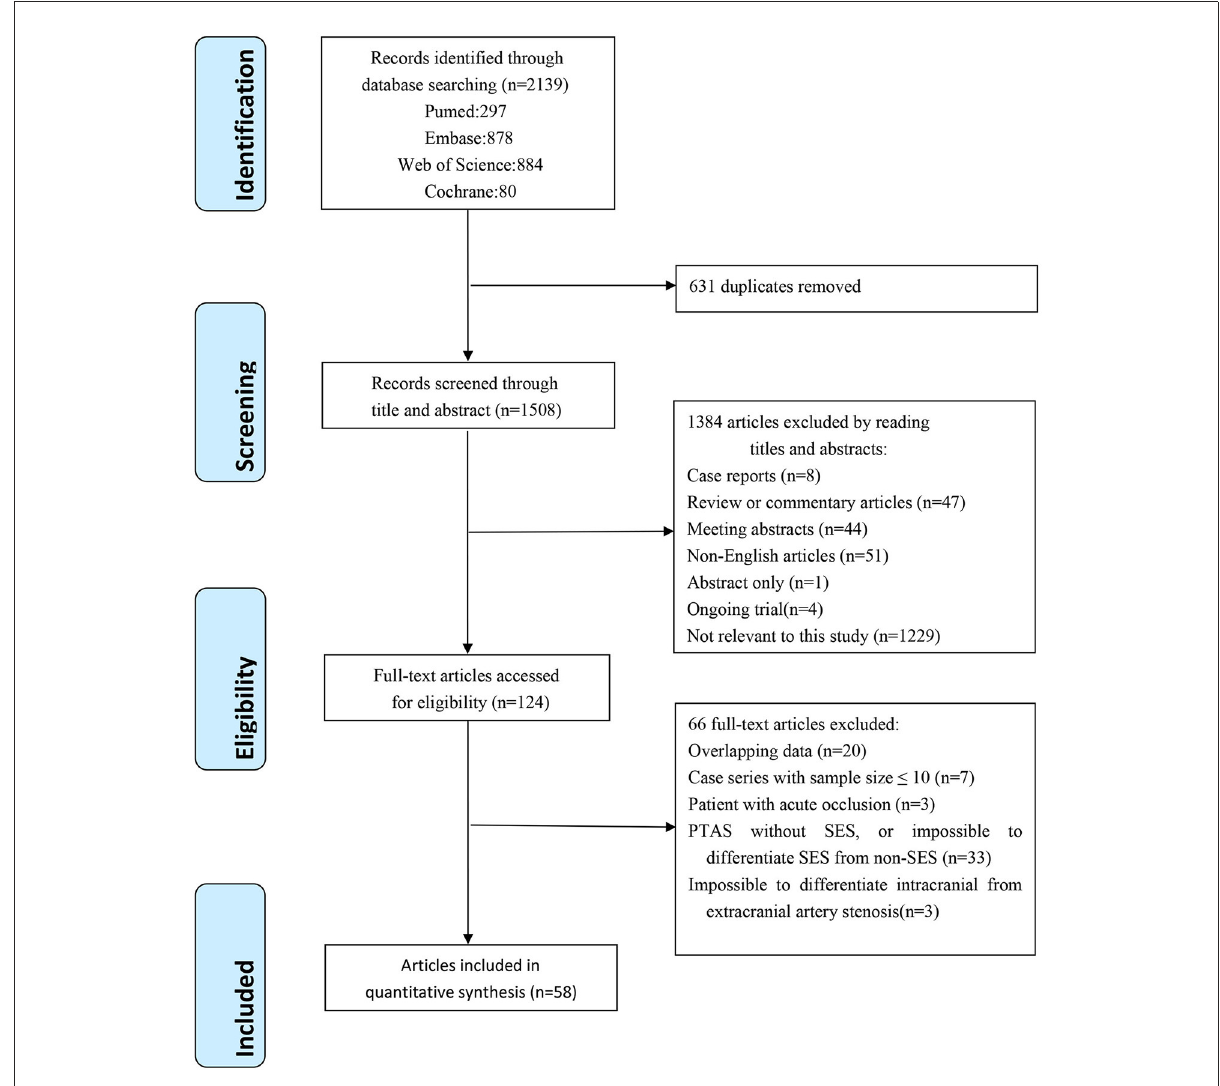
FIGURE1 Flowchart of study